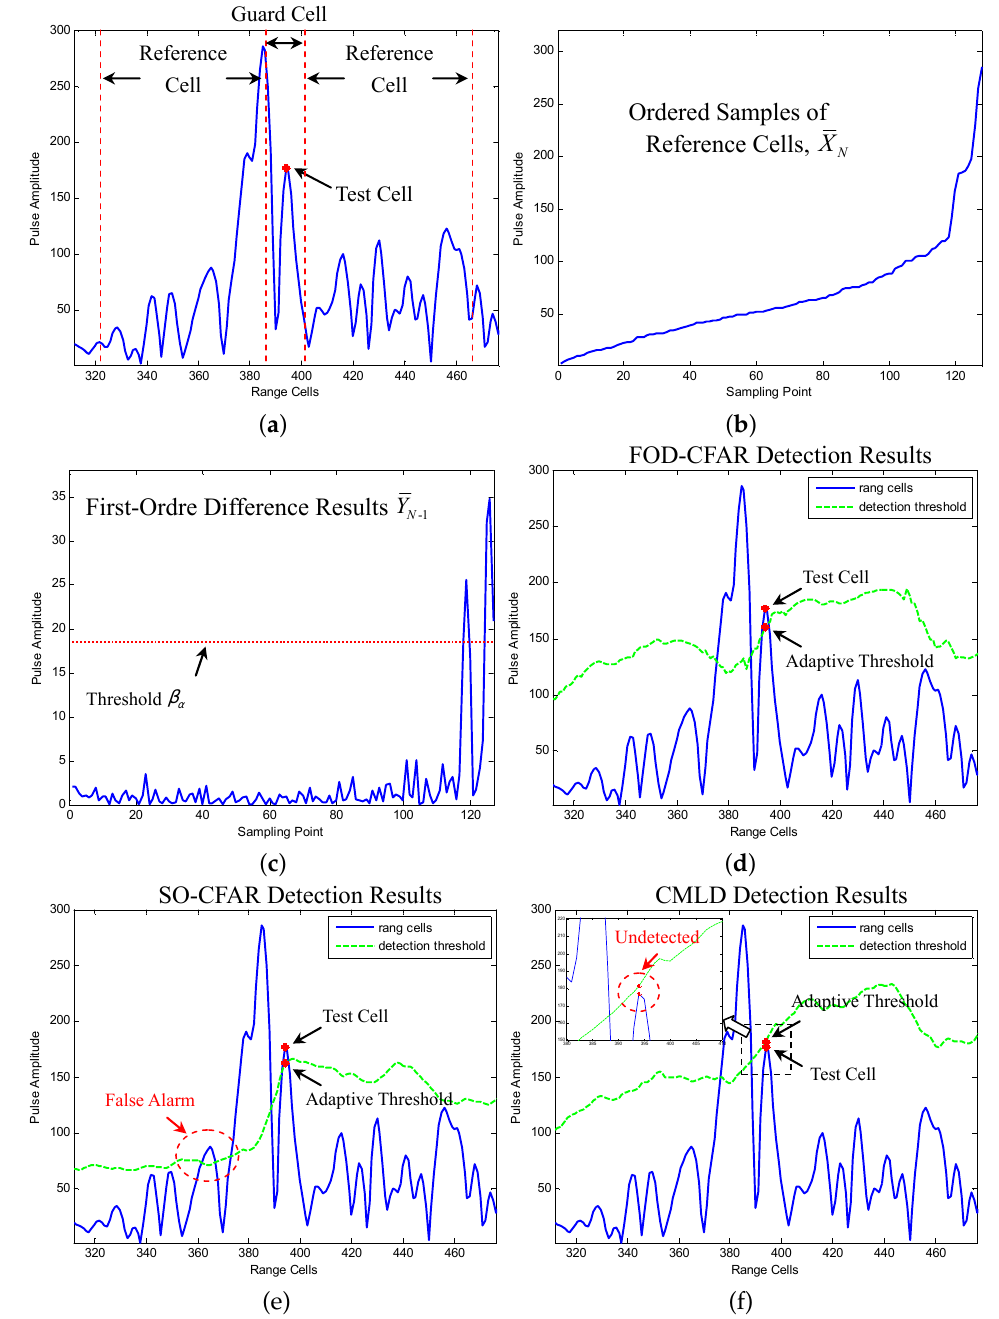
Figure 17. Performance comparison of FOD-CFAR, SO-CFAR and CMLD on a single resolution cell: ( a ) Reference window of the chosen resolution cell; ( b ) Ordered samples ¯ X N of the reference window; ( c ) First-order difference results ¯ Y N − 1 and the threshold β α ; ( d ) FOD-CFAR detection results; ( e ) SO-CFAR detection results; ( f ) CMLD detection